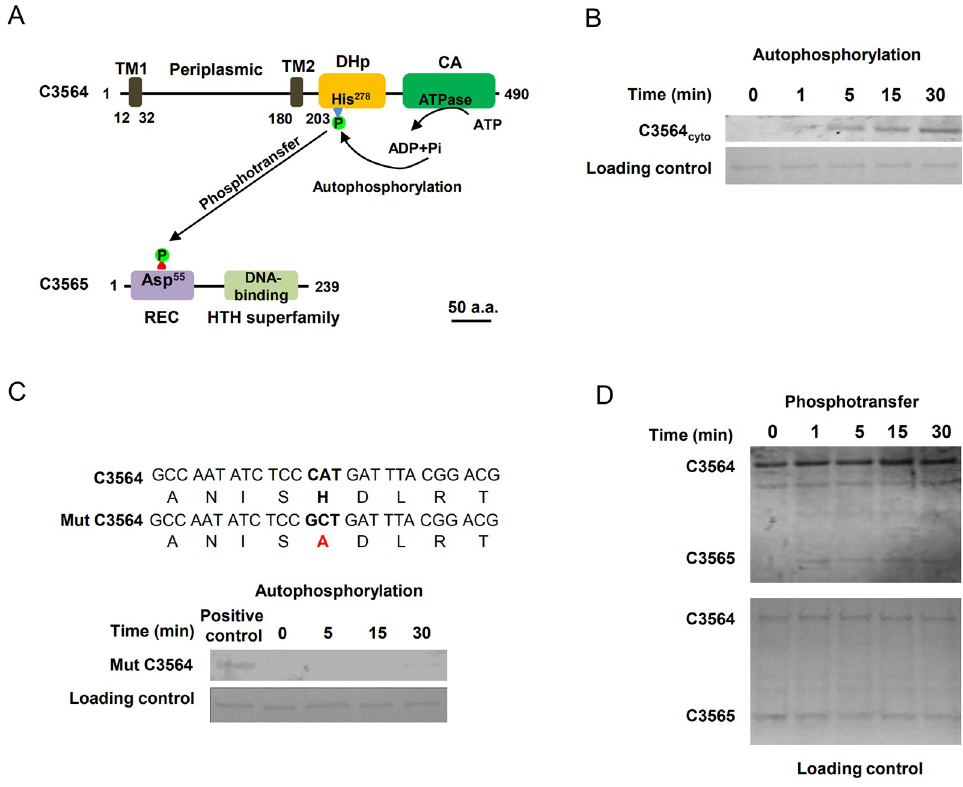
Fig 1. Identification of a two-component signaling system, C3564/C3565, in UPEC CFT073. (A) Domain architectures of C3564 and C3565. The numbers indicate the amino acid positions. The domains were predicted with the InterPro database. Abbreviations: TM1 and TM2, two transmembrane helices; DHp, dimerization and histidine phosphorylation domain containing His278 for autophosphorylation; CA, catalytic ATPase domain; REC, receiver domain containing the putative aspartate residue for receiving the phosphoryl group; HTH, helix-turn-helix domain for DNA binding. The scale bar indicates 50 amino acids (a.a.). (B) In vitro analysis of C3564 autophosphorylation. The purified cytoplasmic portion of C3564 was incubated with ATP for various amounts of time, and phosphorylated proteins were detected using the pIMAGO-biotin phosphoprotein detection method. (C) Mutation of His278 abolished C3564 self-phosphorylation. Mut C3564 is a variant of C3564 carrying a His278Ala mutation, and the positive control is the wild-type C3564 protein. (D) In vitro transphosphorylation of C3565 by phosphorylated C3564. The autophosphorylated form of C3564 and purified C3565 protein were mixed at equimolar concentrations and then incubated at 37˚C for the indicated amounts of time. The reaction mixture was directly subjected to SDS-PAGE and detected by the pIMAGO-biotin phosphoprotein detection method. These experiments were repeated at least twice, and representative images are